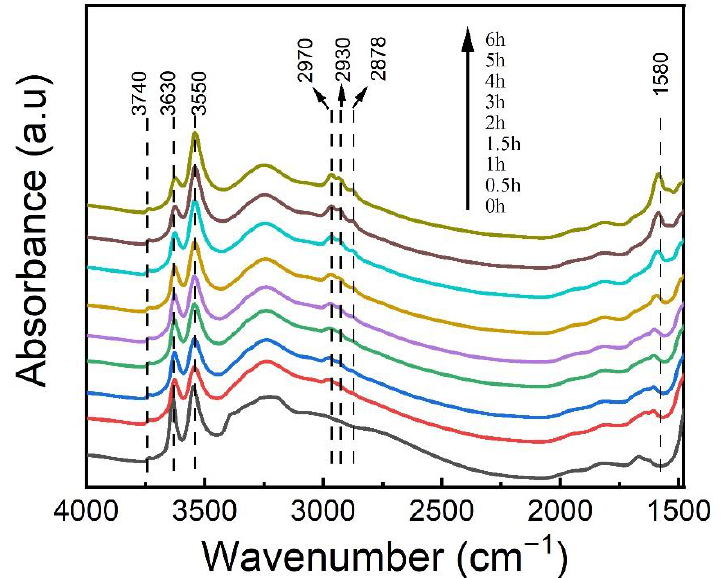
Figure 7. The ammonium hexafluorosilicate modified zeolites hydroxyl groups characterization during the coke formation reaction.